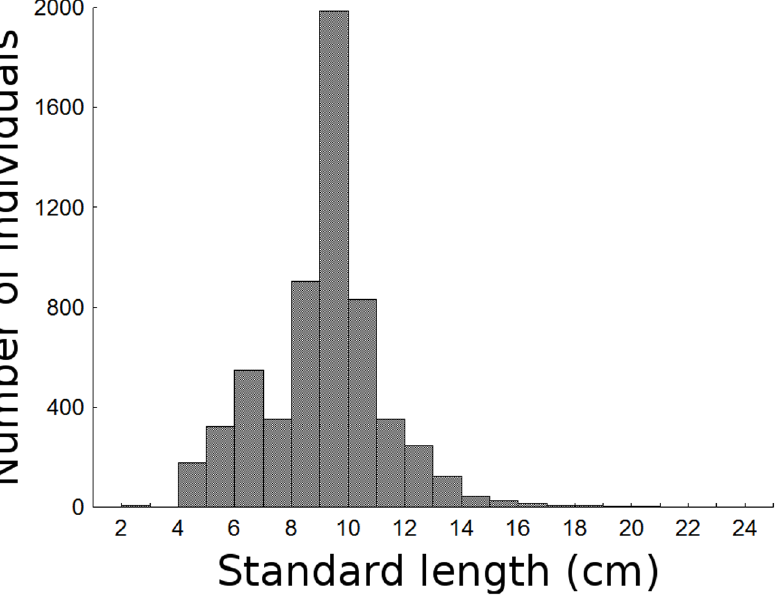
Figure 2. Length-class distribution. Total length- (cm) class distribution for Cathorops spixii sampled in Caraguatatuba Bight from August 2003 through October 2004.